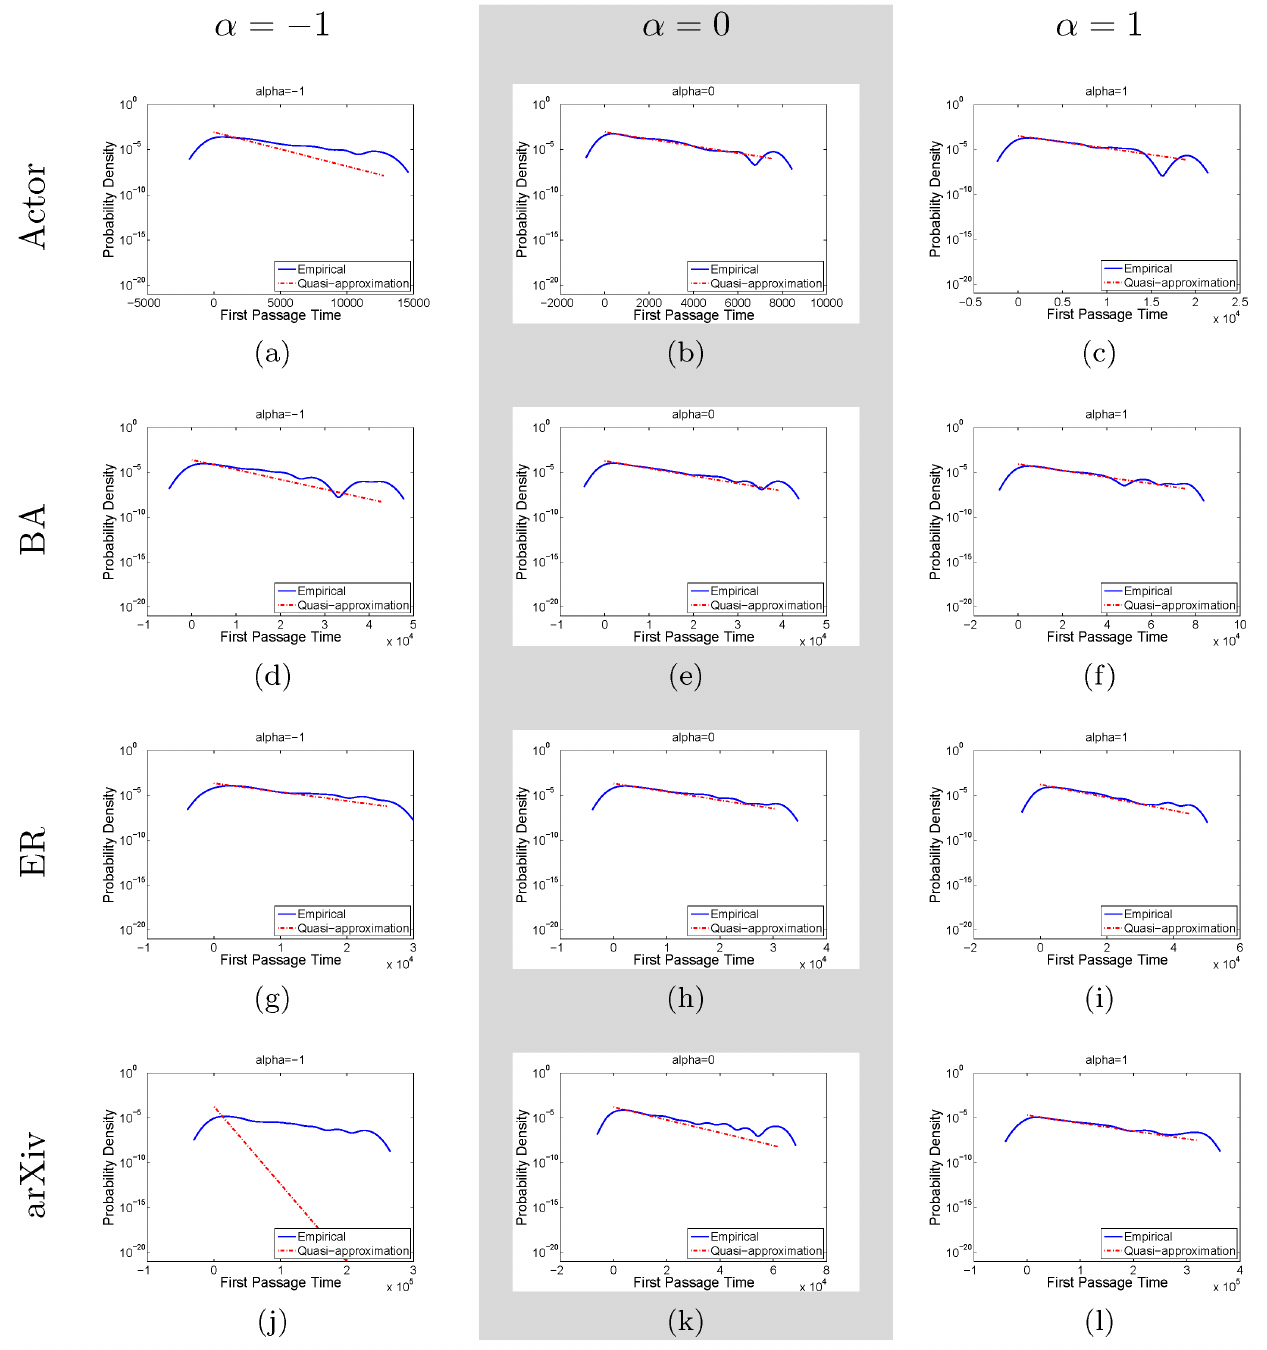
Figure 2. Plots of empirical first passage time distribution against theoretical prediction according to the approximate bound given by Ineq.(13) for different networks and weighting factors. Each row corresponds to a network in the following order: Actor, BA, ER, and arXiv. The columns, from left to right, correspond to a ~{ 1 , 0, 1 respectively. For most cases, the tail of the first passage time distribution can be predicted fairly accurately except for Figure 2(j), which is due to the high relaxation time as shown in Table